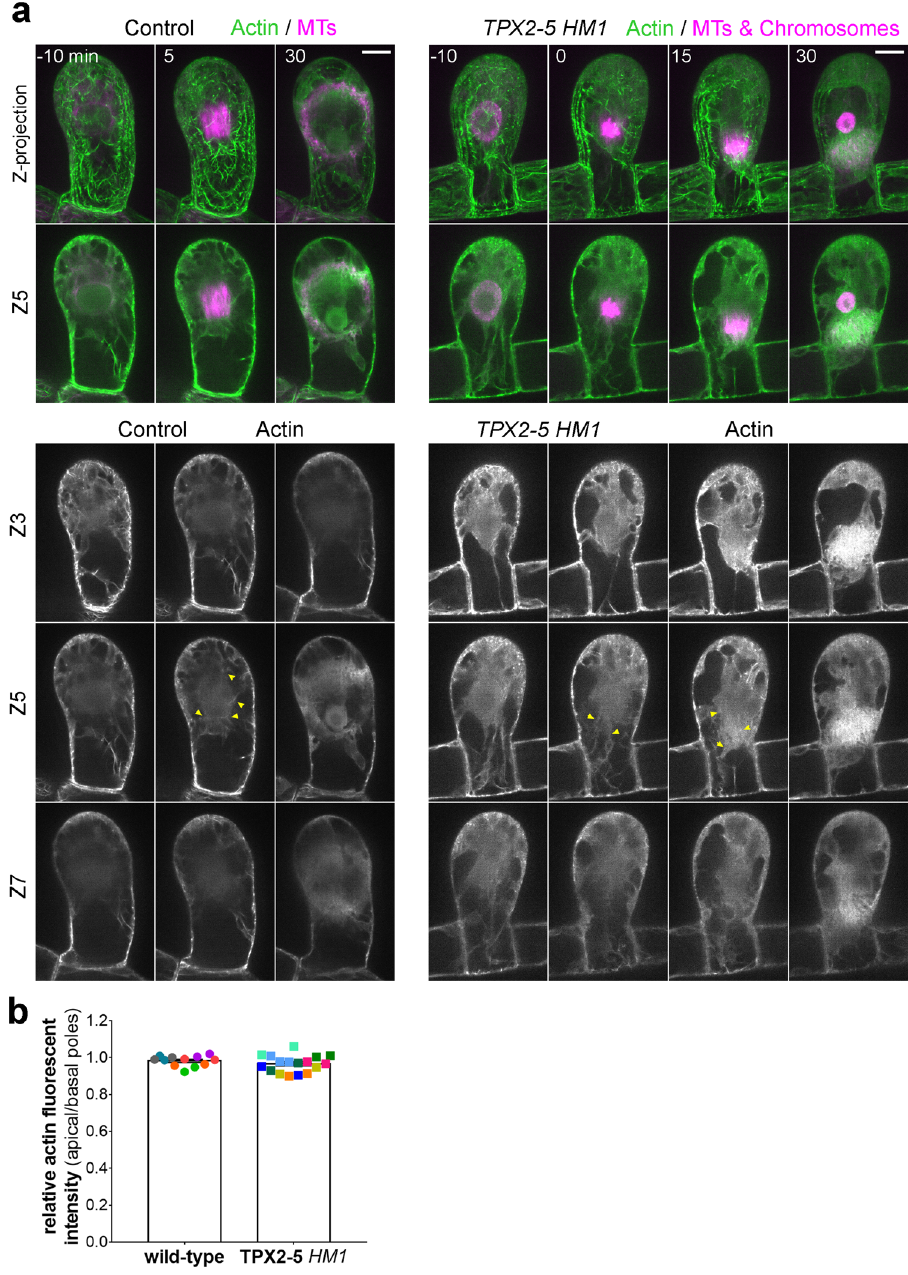
Fig. 6 Actin is present in the cytoplasm and cortex during spindle motility in the TPX2-5 HM1 line. a Live-cell imaging of Citrine-F-tractin (actin, green) during the fi rst asymmetric division in the gametophore initial cells also expressing mCherry-tubulin (magenta, MTs). TPX2-5 HM1 cells additionally expressed mCherry-tubulin/H2B-RFP (magenta, chromosomes), which was brighter than mCherry-tubulin. Maximum intensity projection of Citrine-F- tractin (20 µ m with 2.5 µ m steps) and single focal frame of mCherry-tubulin were merged in the “ Z -projection ” panels. Three Z frames are also presented ( z = 3, 5, and 7). Yellow arrowheads indicate fi lamentous or punctate signals of cytoplasmic actin. Time 0 (min) was set at NEBD. Bar, 10 µ m. b Relative actin fl uorescent intensity (basal/apical poles). Mean gray values of Citrine-f-tractin were measured at the apical and basal pole of the spindle in a square of a fi xed size (8 × 4 µ m) for each of the Z-slices and summed to get intensity at each pole. Dots of the same color represent measurements obtained from the same cell at different time points ( n = 6 and 8 for wild-type and TPX2-5 HM1 ,